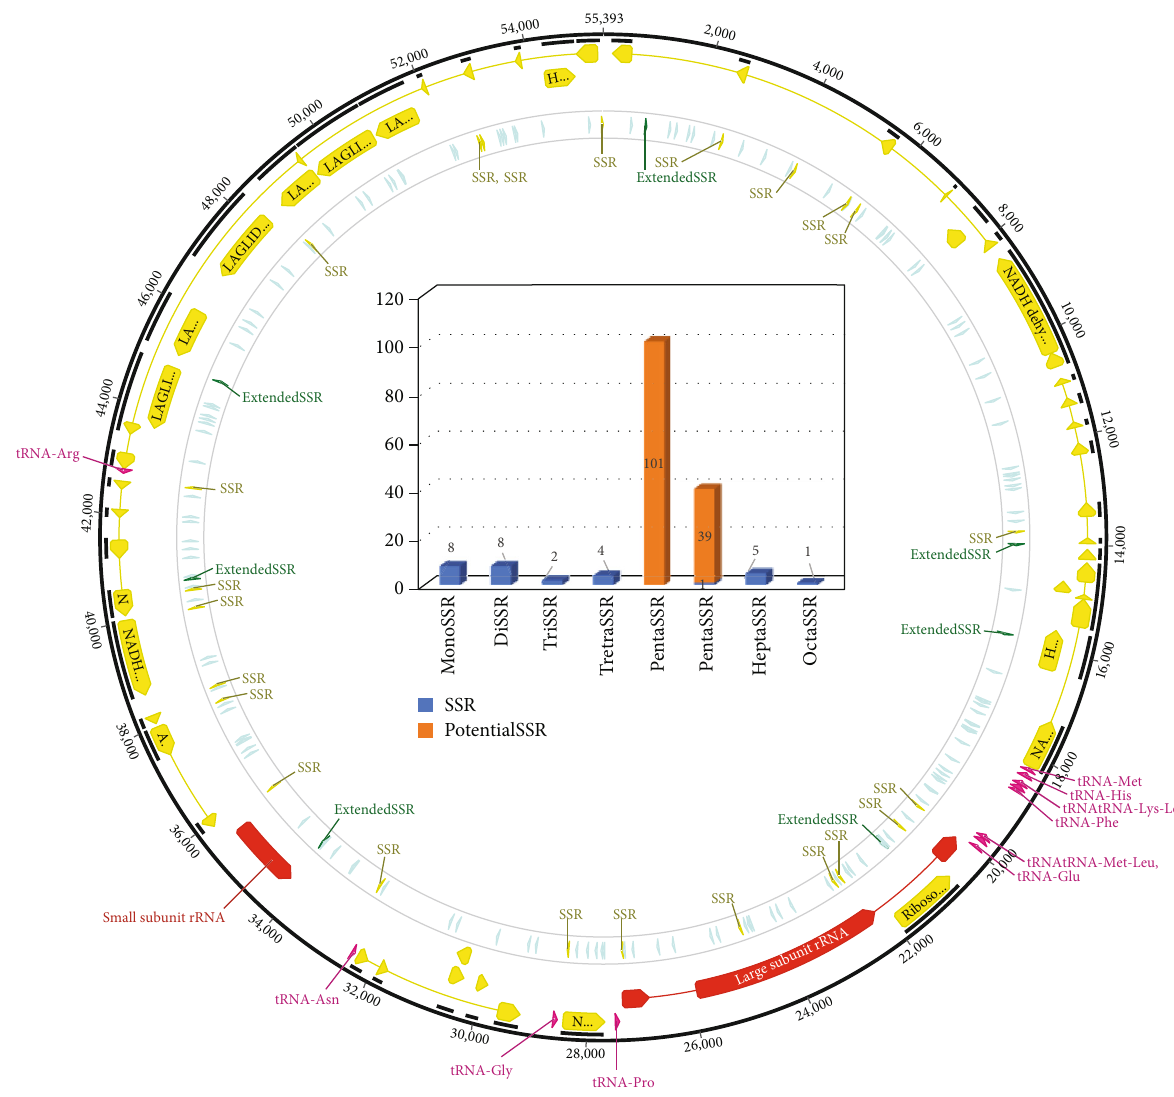
Figure 3: Numbers and distribution of SSRs on the mitogenome of fungal endosymbiont of WBPH KR. (a) Black circle indicates fungal endosymbiont mitogenome, yellow arrows are protein-coding genes, purple arrows are tRNAs, and red arrows mean rRNAs. SSRs, extended SSRs, and potential SSRs are displayed with yellow, green, and light green colors, respectively. (b) The number of SSRs along with SSR types is displayed. Blue color indicates SSRs and extended SSRs, and orange color means potential